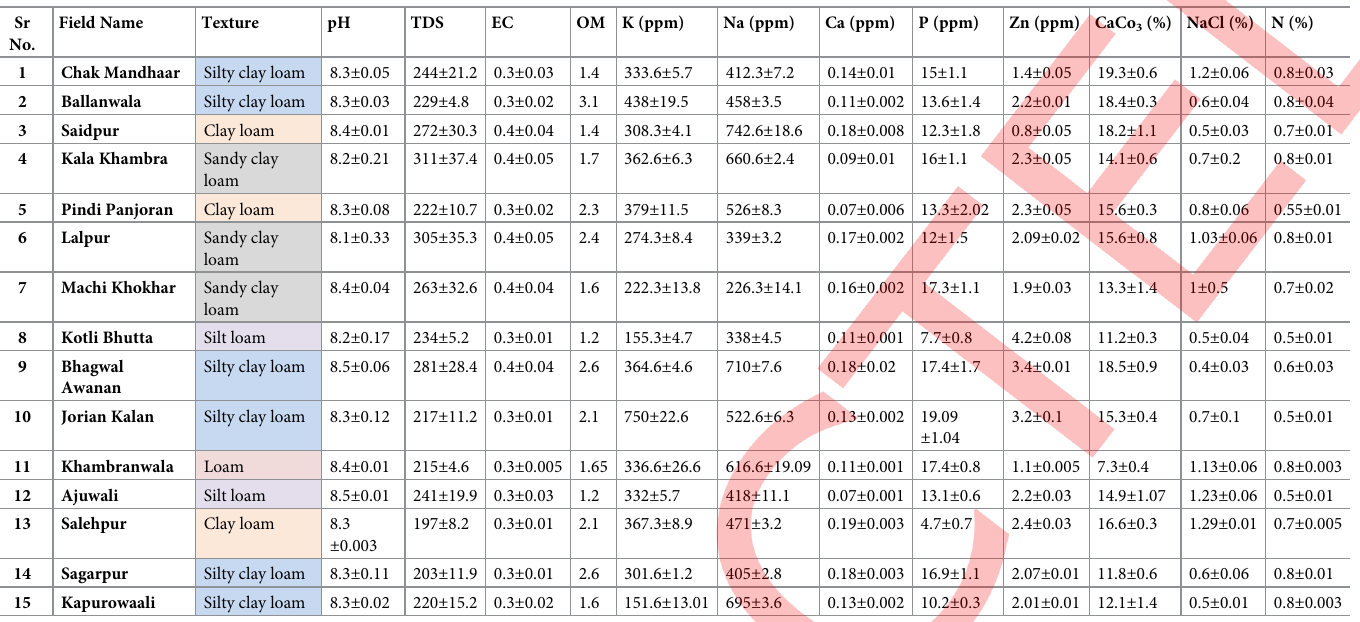
Table 1. Physicochemical properties of the soil at 30˚C of wheat fields of